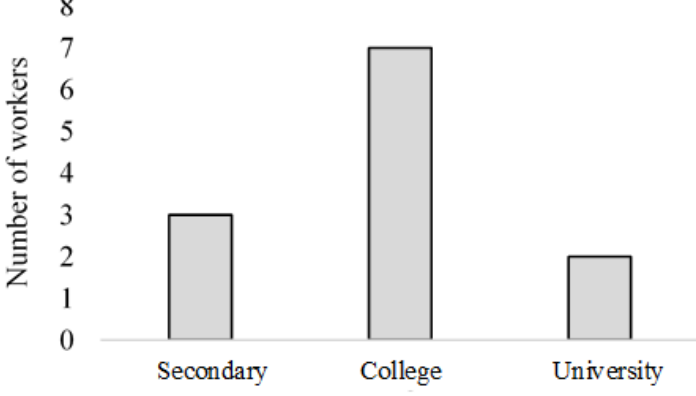
Figure 3. Education received by employees in charge of planning.